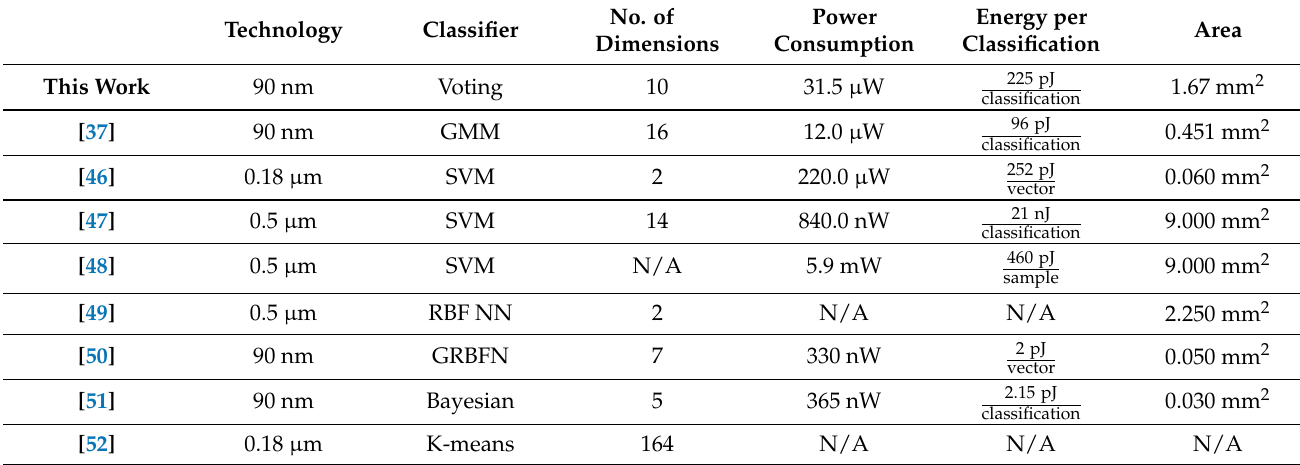
Table 4. Analog ML algorithm